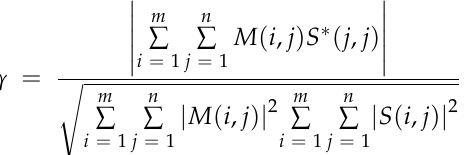
Table 1. Statistics of residual phases.